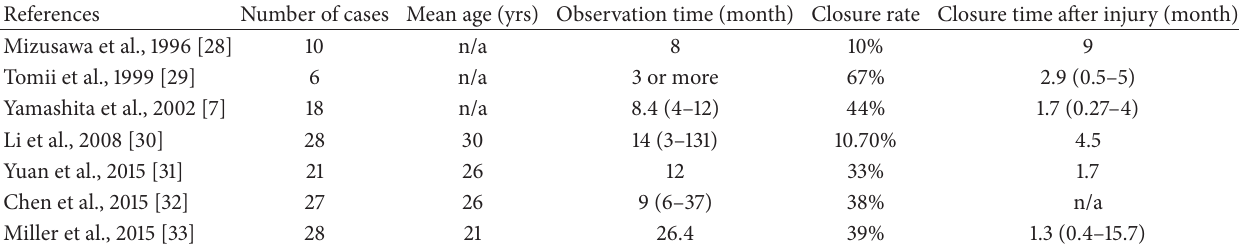
Table 2: Literature review of case series reports on spontaneous closure rate of